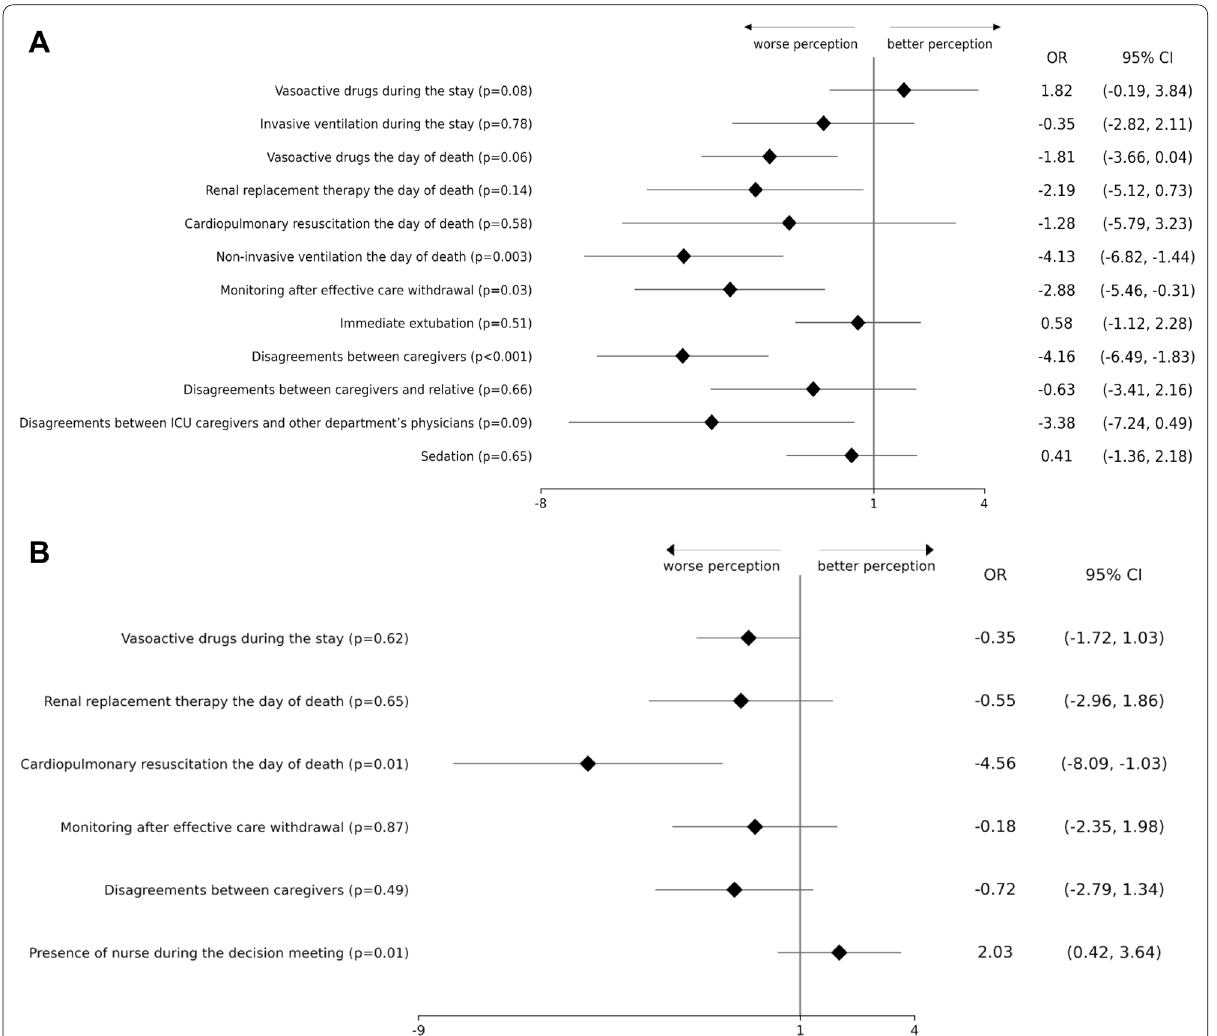
Fig. 2 A Factors associated with nurses’ CAESAR score in multivariable analysis with random-effect multilevel logistic regression (Forest plot). B Factors associated with physicians’ CAESAR score in multivariable analysis with random-effect multilevel logistic regression (Forest